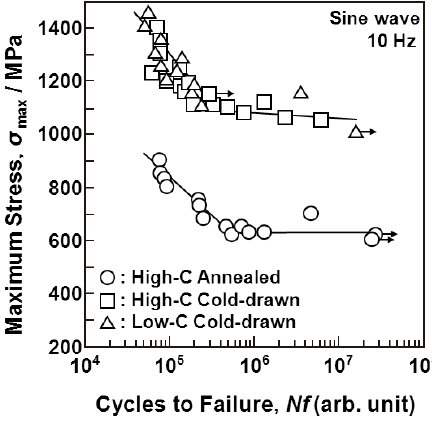
Figure 9. S-N curves obtained by tension-to-tension fatigue test with sine wave (10 Hz) for annealed high-C Co-Cr-Mo-Ni and 50% cold-drawn high-C and 50% cold-drawn low-C Co-Cr-Mo-Ni alloy